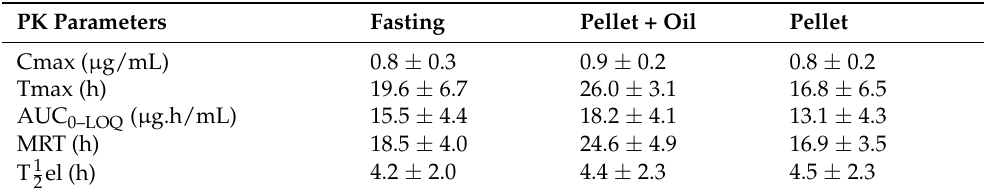
Table 2. The pharmacokinetic parameters (expressed as mean ± SD) for albendazole sulphone (ABZSO 2 ) after the oral administration of albendazole (ABZ) (10 mg/kg) to pigs fed under different dietary regimens. PK